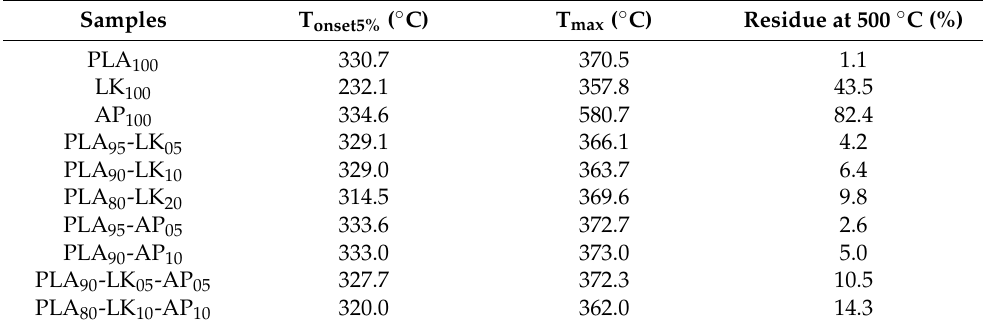
Table 5. Thermogravimetry data of PLA, LK, AP, PLA-LK, PLA-AP and PLA-LK-AP